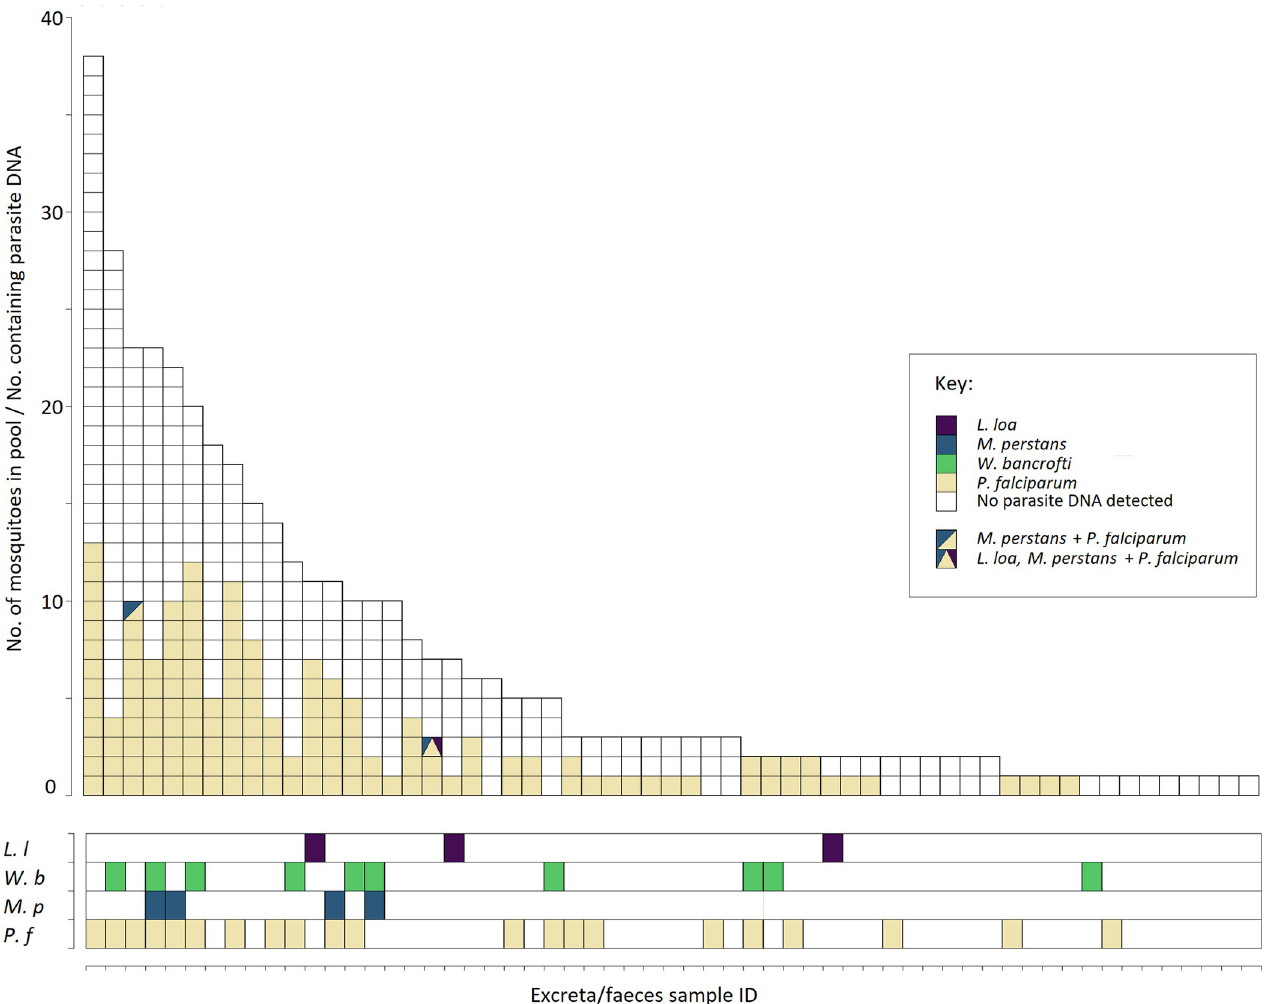
Fig 2. Upper: The number of mosquitoes contributing to each of the 59 excreta/feces samples and proportion of individual mosquitoes found to be positive for L . loa , M . perstans , W . bancrofti or P . falciparum DNA. Lower: corresponding presence or absence of the four parasites’ DNA in each of the collected excreta/feces samples. Abbreviations: L. l– L . loa ; W. b– W . bancrofti ; M. p– M . perstans ; P. f– P . falciparum